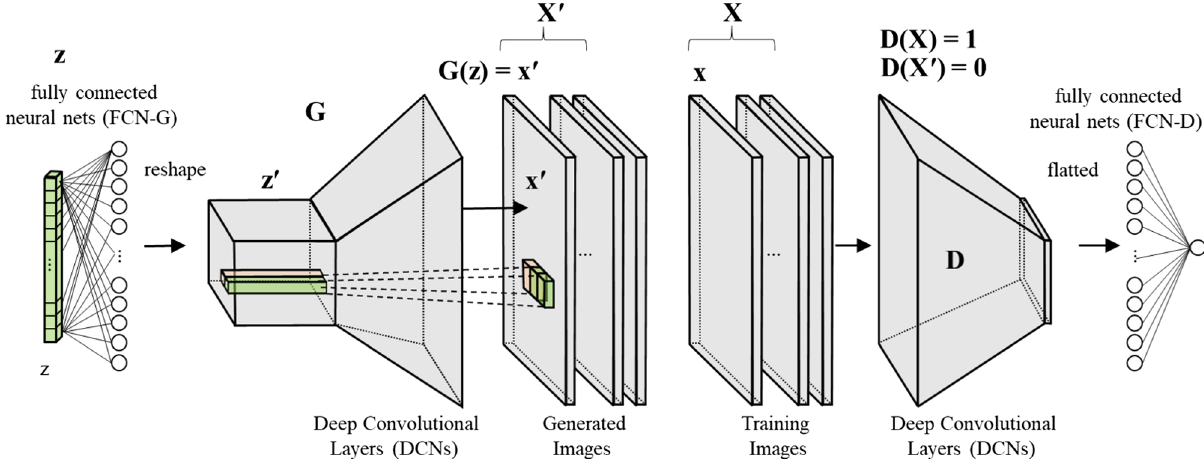
Figure 1. Schematic representation of DCGANs: the deep convolutional neural networks were utilized to develop the